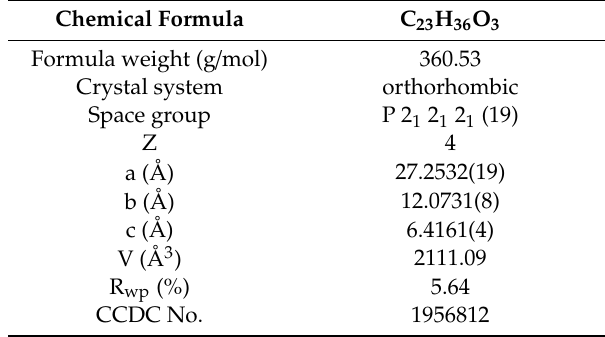
Table 2. Drost 1 crystal data * .